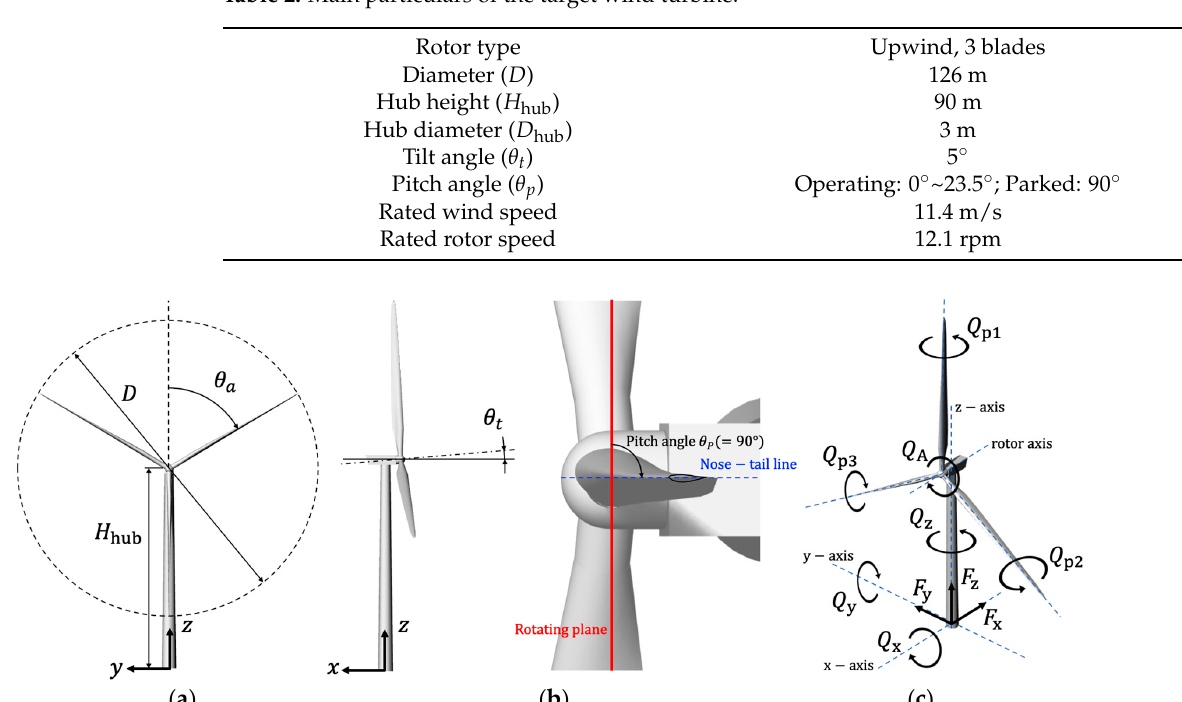
Table 2. Main particulars of the target wind turbine. Figure 8. Time history of wind speed in a gust period.